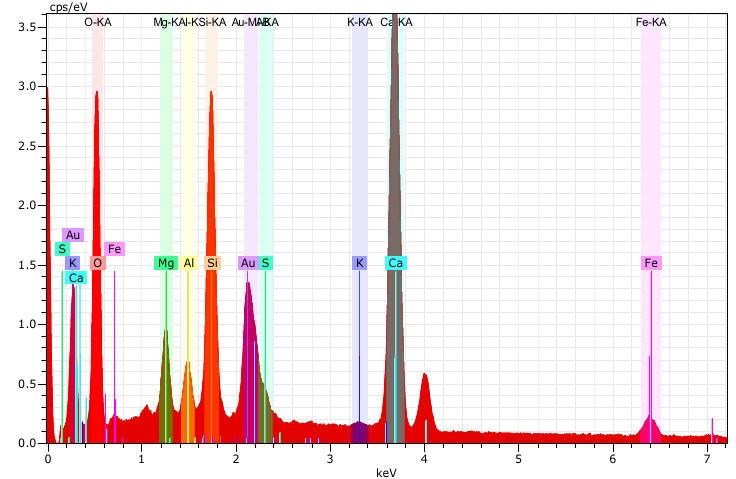
Figure 2. Energy-dispersive X-ray (EDS) spectrum of the sample from Figure 1c.